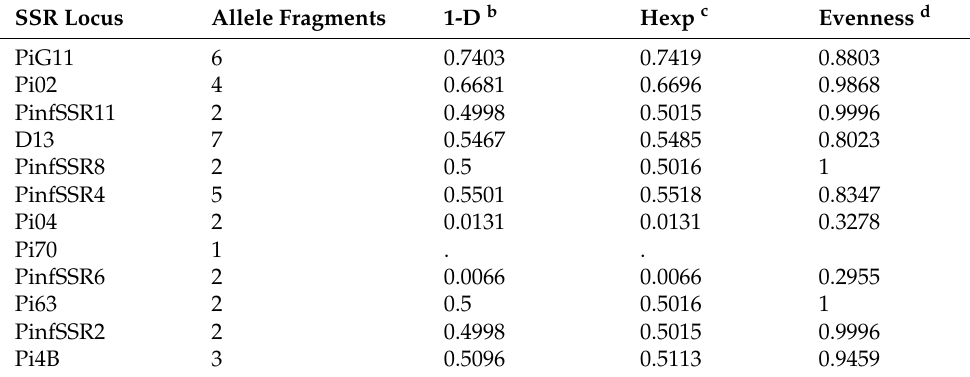
Table 1. Summary of microsatellite (SSR) marker information and locus statistics of 152 Phytophthora infestans isolates in Egypt in 2013–2018 and 15 reference isolates.